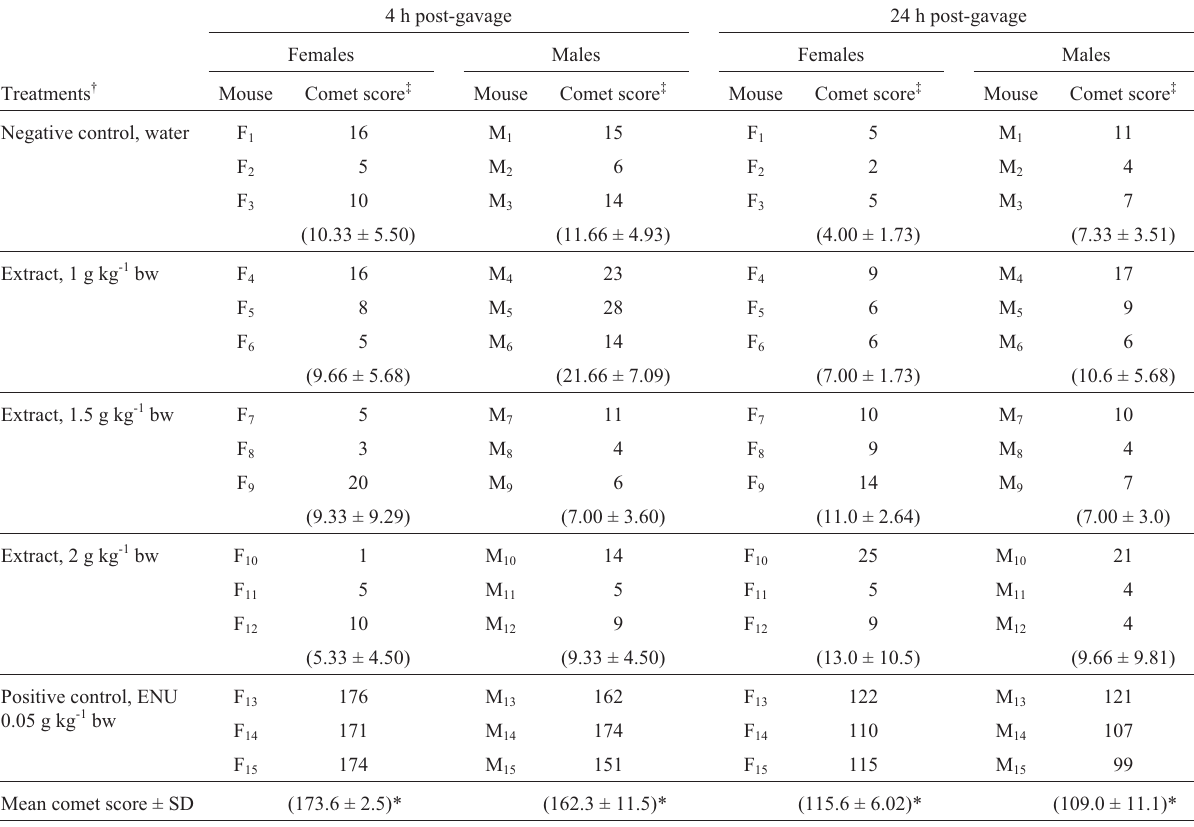
Table1 -Cometassayforthe invivo assessmentofgenotoxicityofa Vacciniumcorymbosum hydroethanolicextractonperipheralbloodleukocytesfrom 12-week old female (F 1 to F 15 ) and male (M 1 to M 15 ) Swiss mice (body weight (bw) 25 g to 30 g) exposed to different concentrations of extract 4 h and 24 hbeforetheassay.Eachtreatmentusedthreemice(n=3).Foreachmousetotalcometscorewascalculatedasthecometclass(1,2or3)multipliedbythe number in the class ( i.e. 1 in class 1 = 1, 1 in class 2 = 2 and 1 in class 3 = 3). The negative control was water and the positive control was N-nitroso-N-ethylurea (ENU). 4 h